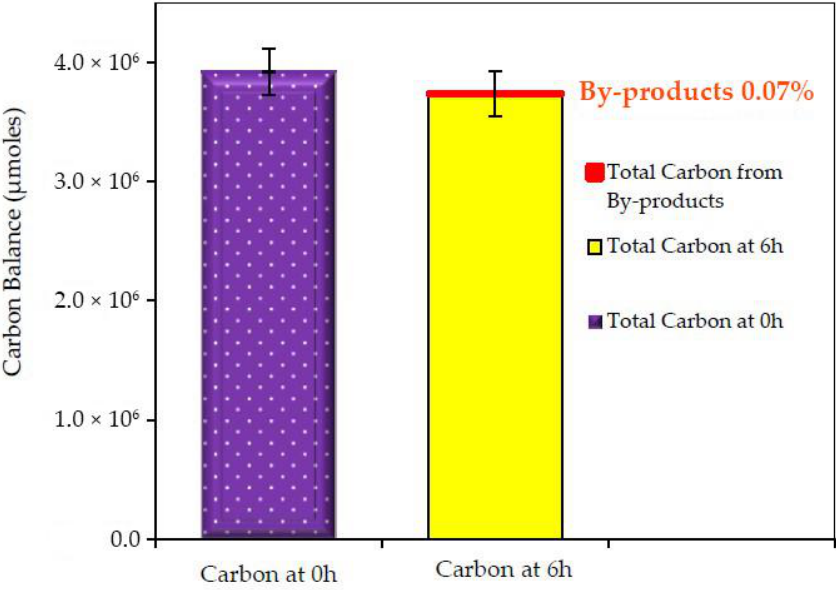
Figure 7. Total carbon in all carbon containing species at the beginning of the reaction and after combined near-UV irradiation (1 h) and visible light irradiation (5 h). Conditions: argon atmosphere, 0.25 wt% Pd-TiO 2 -VIS photocatalyst